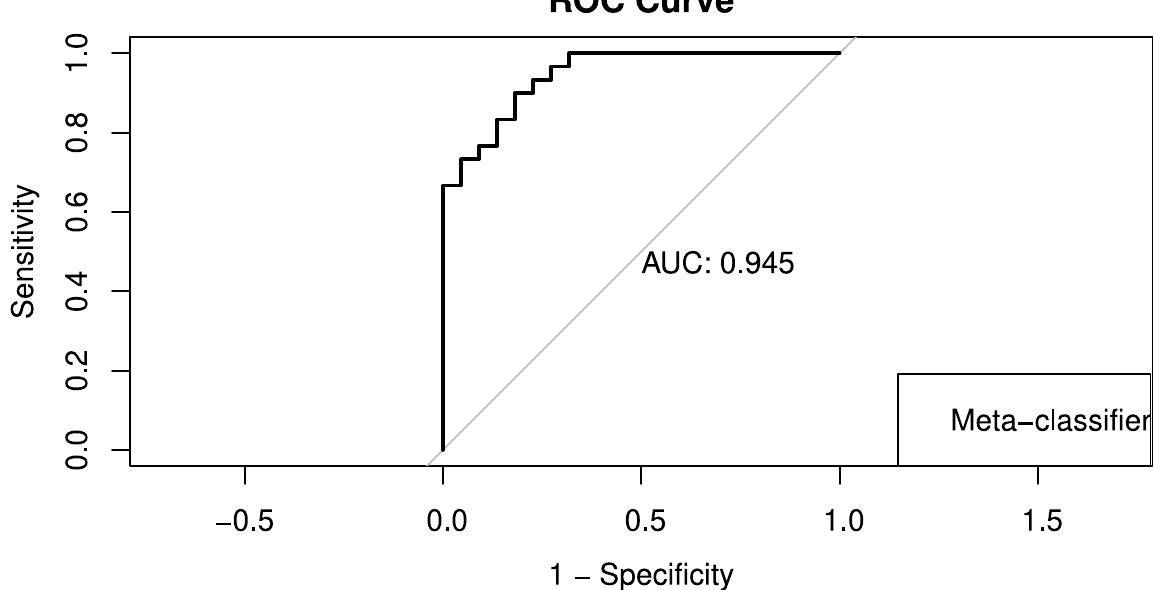
Figure 6. Receiver operating characteristic curve for the meta-classifier model on the testing dataset. The horizontal axis represents the false-positive rate (1-Specificity). The vertical axis represents the true-positive rate